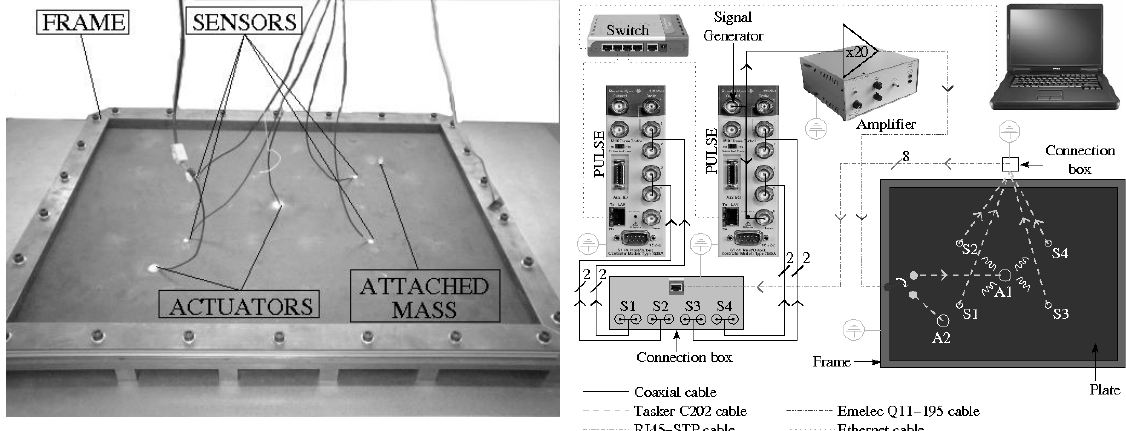
Fig. 1. Plate with mass M1 attached (left) and connection diagram of the experiment